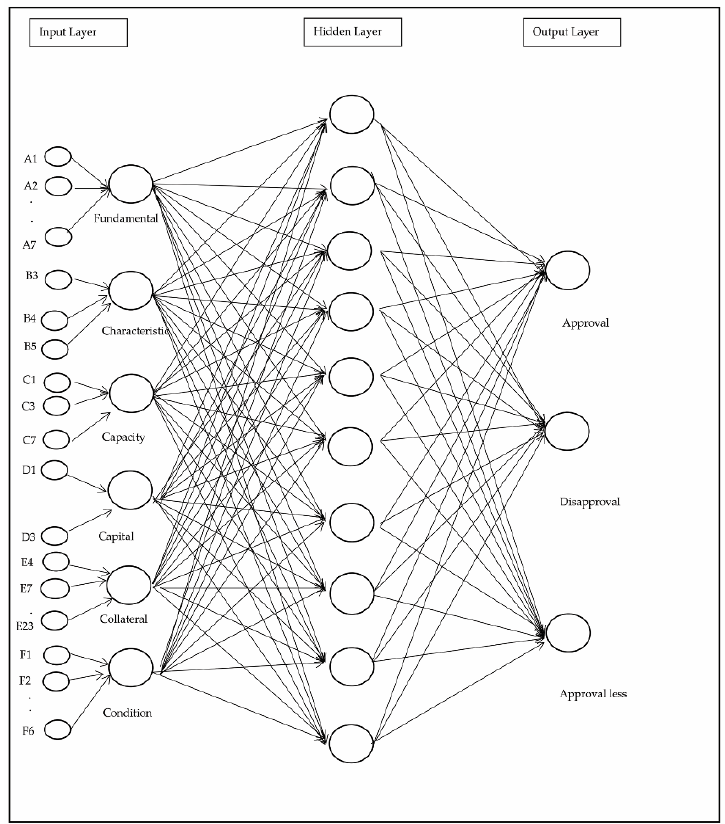
Figure A6. Structure of the NN by using Pareto technique ( 80 :20) model used for predicting.